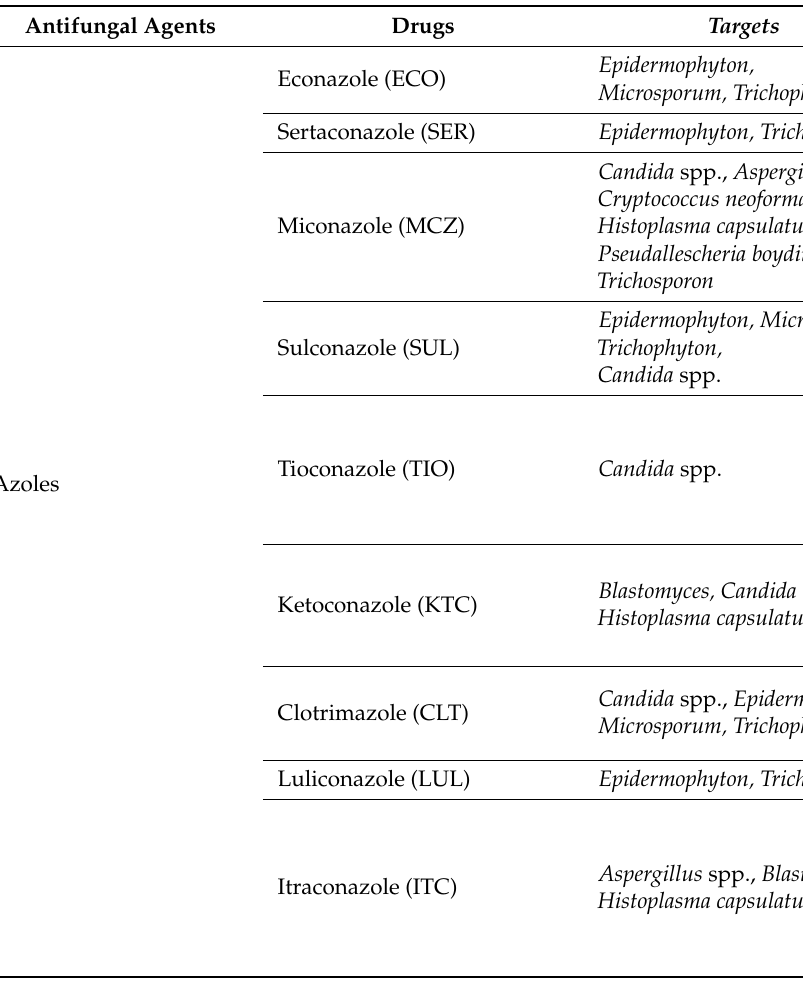
Table 2. Conventional anti-fungal